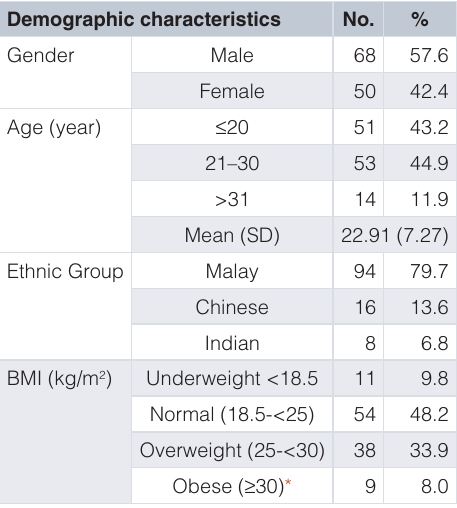
Table 1. Characteristics of the study